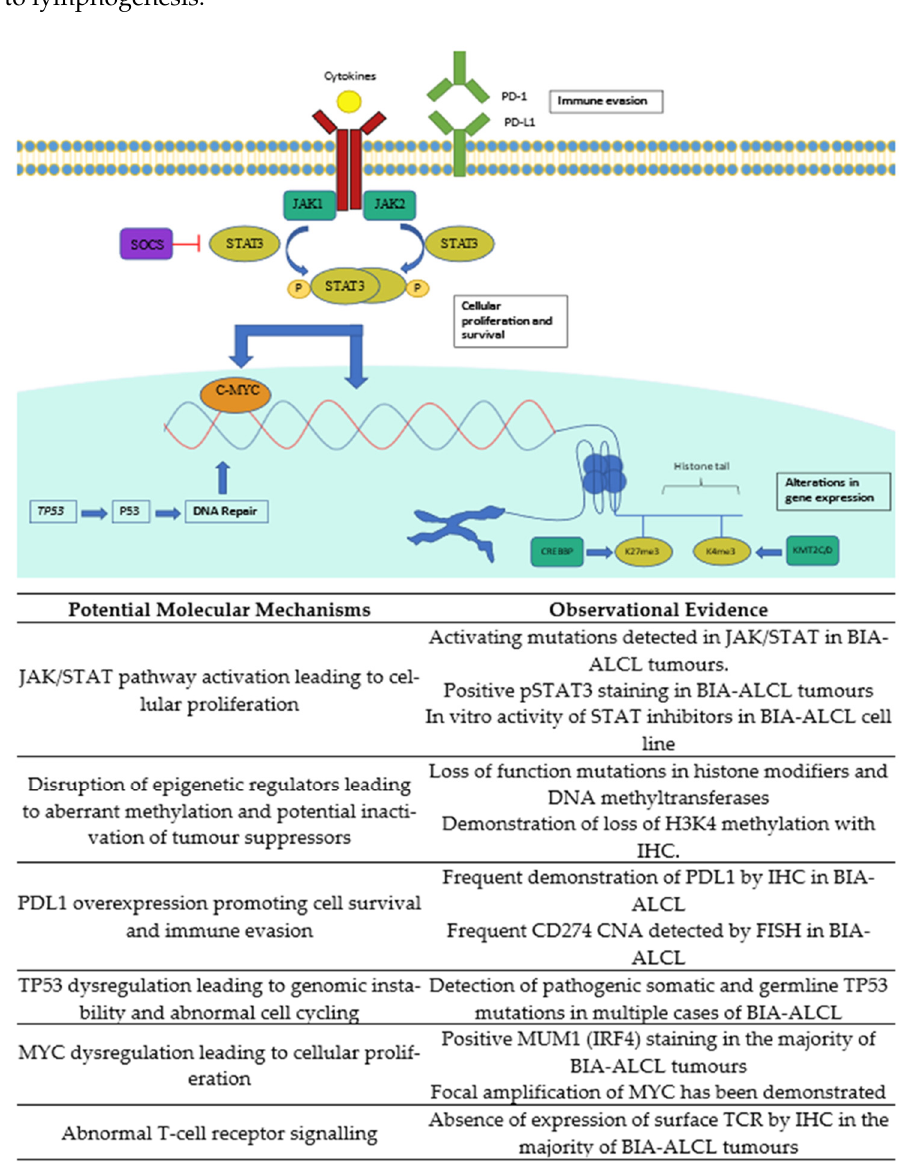
Figure 1. Summary of the molecular pathways potentially contributing to lymphogenesis. IHC,